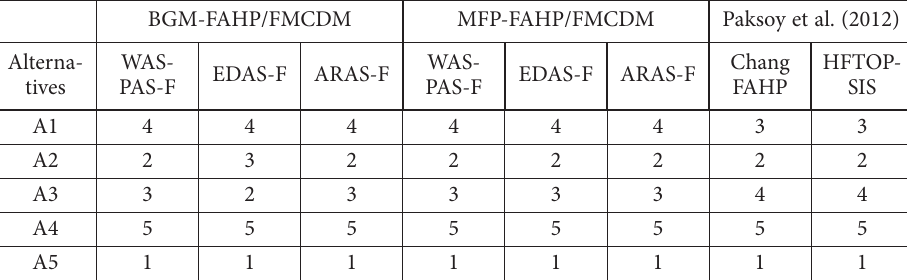
Table 12. Ranking results of proposed methods, FAHP and